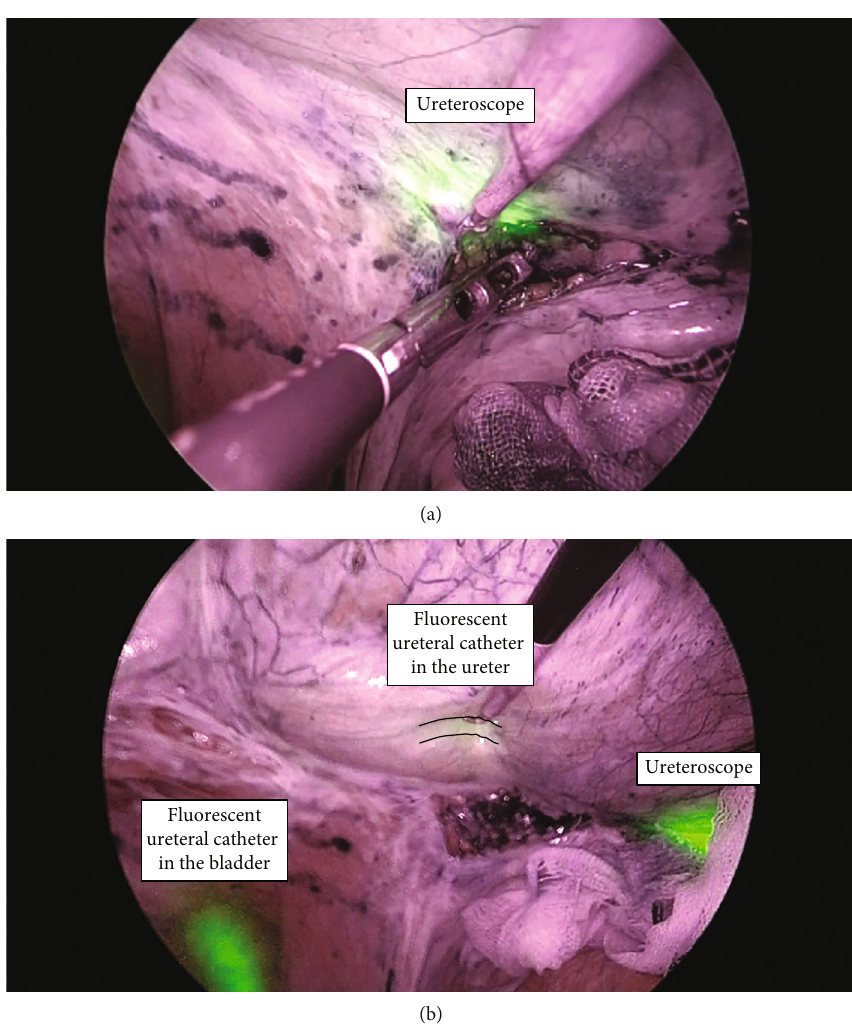
Figure 2: Intraoperative imaging in near-infrared mode. (a) The light source of the ureteroscope appears green. The thickened lymphocele wall is incised with a cautery hook while appropriately checking the light source of the ureteroscope in real time. (b) The fl uorescent ureteral catheter in the bladder can be easily observed due to the green fl uorescence. By compressing the cyst from the peritoneal cavity using forceps, the fl uorescent catheter in the ureter can be safely checked (broken line). The light source of the ureteroscope is also visible as it appears